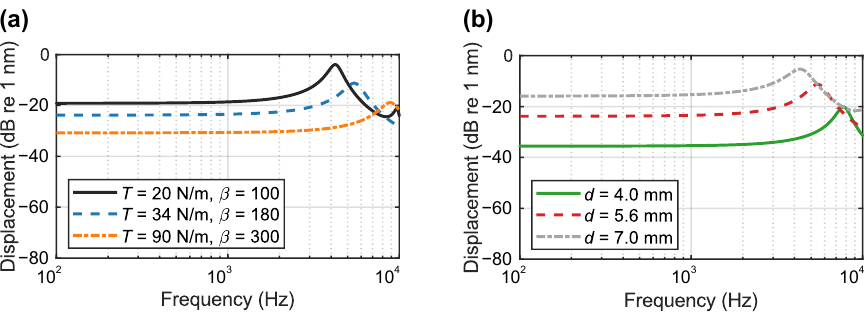
Figure 3. The analytical displacements of the membrane ( a ) with three tension values and the adjusted damping factors, and ( b ) with three diameter